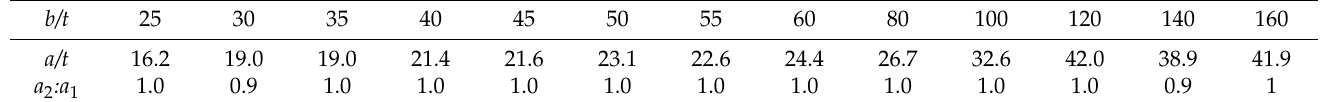
Table 8. Optimum values of a/t and a 2 :a 1 .